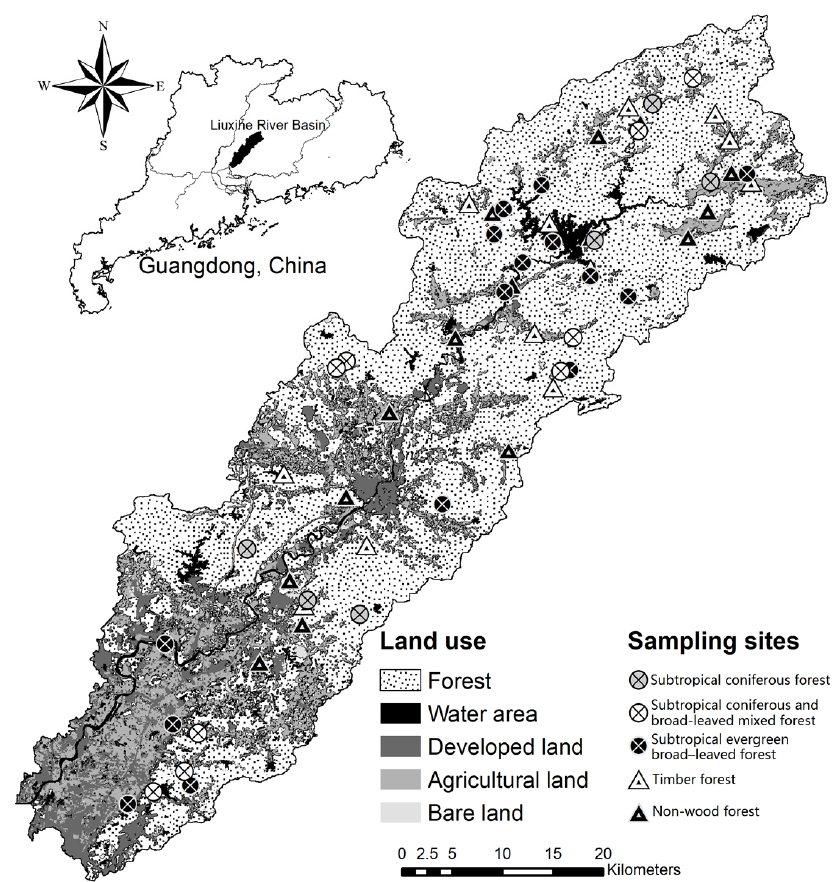
Figure 1. Land use in the study area and the distribution of the sampling sites.